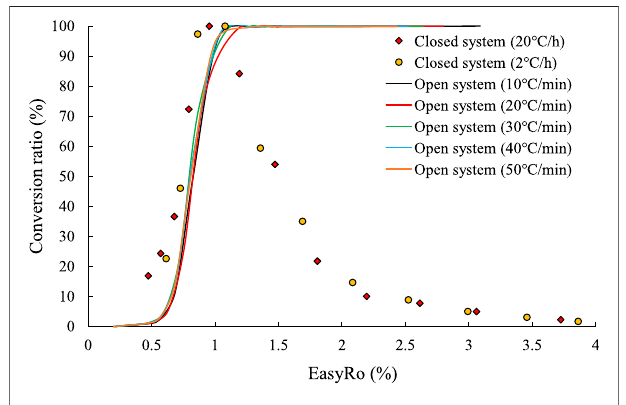
FIGURE 5 | Comparison of the conversion ratio of the liquid hydrocarbons in the open system and closed system